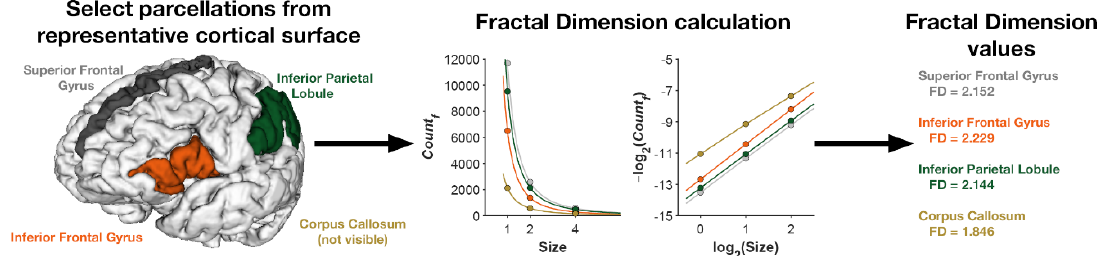
Figure 1. Illustration of the fractal dimension calculation. Individual parcellated regions (or the entire cortical ribbon) are isolated. For each region, the number of voxels at each respective box size is across different spatial resolutions, adjusting for alignment of the ‘boxes’ to the structure using the dilation algorithm. The counts and box sizes are then log-log transformed and the slope calculated. The slope in log-log space is taken as the fractal dimension of the region.